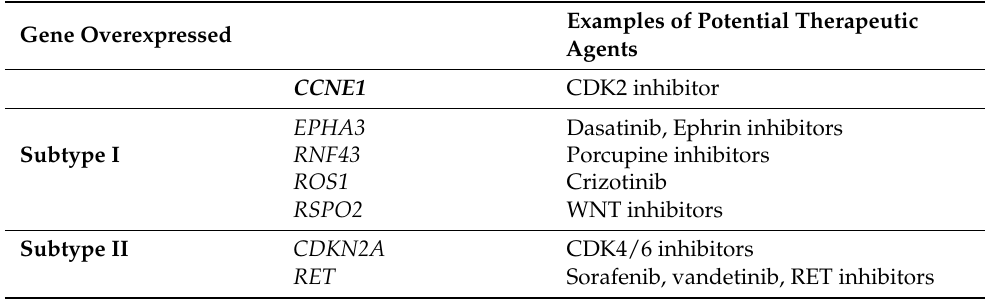
Figure 7. Different gene expression signatures in different eMPM molecular subtypes are shown by GSEA. ( A ) Different gene expression patterns in subtype I and subtype II are represented. Genes that are overexpressed are red, while genes that are under-expressed are blue. ( B ) In subtype I, GSEA demonstrates the activity of the ECM receptor interaction and WP gastric cancer network. ( C ) In subtype II, GSEA revealed the activation of the fatty acid metabolism pathway and cytoplasmic ribosomal proteins pathways. Table 2. Target genes enriched in each molecular subtype of